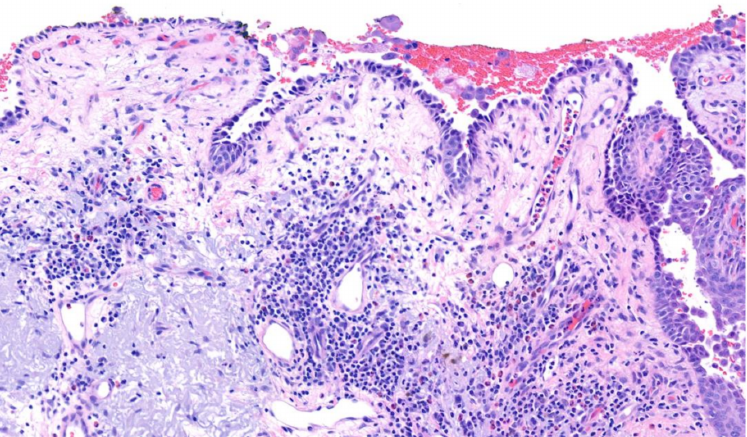
Figure 2. Pemphigus vulgaris. Suprabasilar acantholysis with follicular involvement and ‘tombston- ing’ of basilar